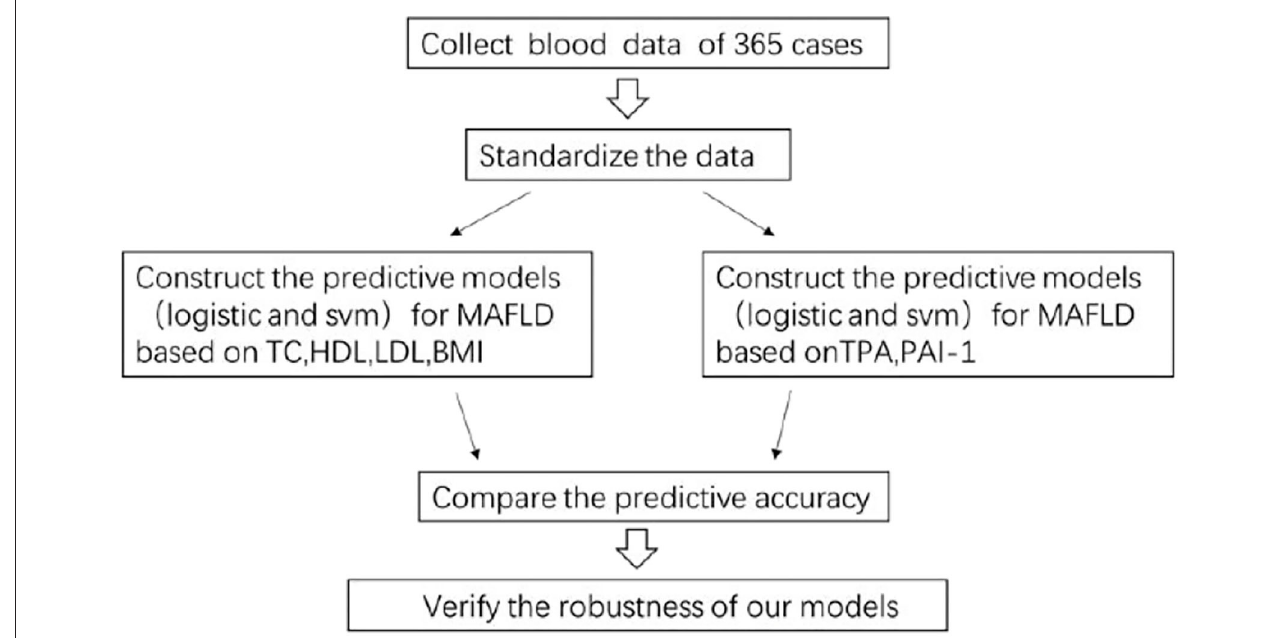
FIGURE 1 | The technical line of our research.